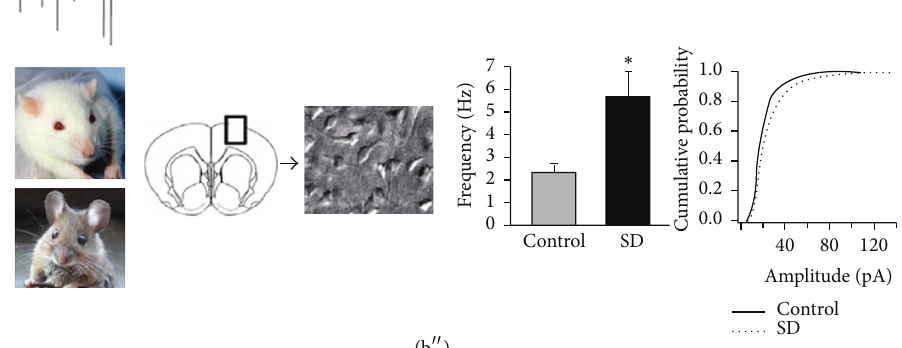
Figure 2: Evidence for synaptic potentiation in sleep deprivation [18]. (a) Experiments in rats and mice show that the number and phosphorylation levels of GluA1-AMPARs increase after wake [18, 21]. ((b), (b 󸀠 ), and (b 󸀠󸀠 )) Electrophysiological analyses of cortical evoked responses using electrical stimulation in rats [18, 21] and TMS in humans [18, 22] show increased slope after wake and decreased slope after sleep. In (b), W0 and W1 indicate onset and end of ca. 4 hours of wake; S0 and S1 indicate onset and end of ca. 4 hours of sleep, including at least 2 hours of NREM sleep. In (b 󸀠 ), pink and blue bars indicate a night of sleep deprivation and a night of recovery sleep, respectively. (b 󸀠󸀠 ) In vitro analysis of miniature excitatory postsynaptic currents (mEPSCs) in rats and mice shows increased frequency and amplitude of mEPSCs after wake and sleep deprivation (SD) relative to sleep (control) [18,